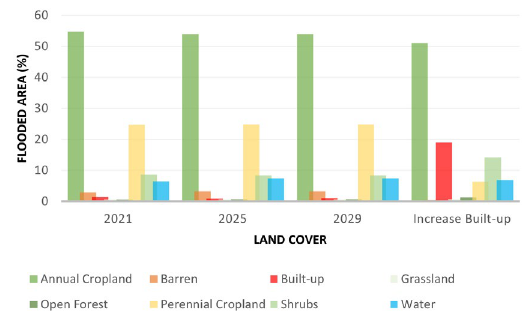
Figure 17. Flooded areas for each land cover with a 50-year rainfall return period.